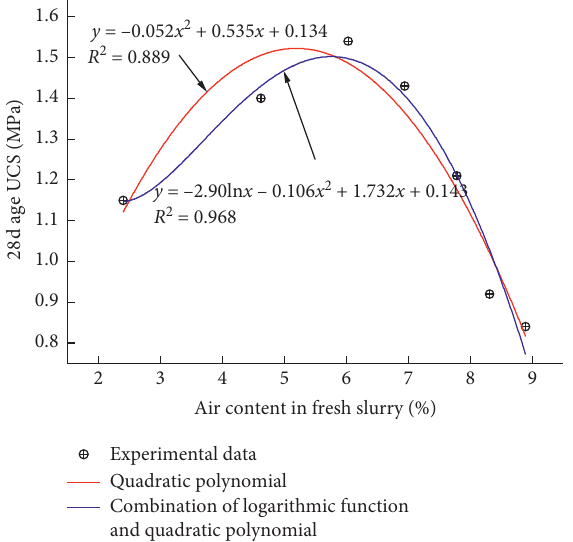
Figure 8: Comparison of two mathematical